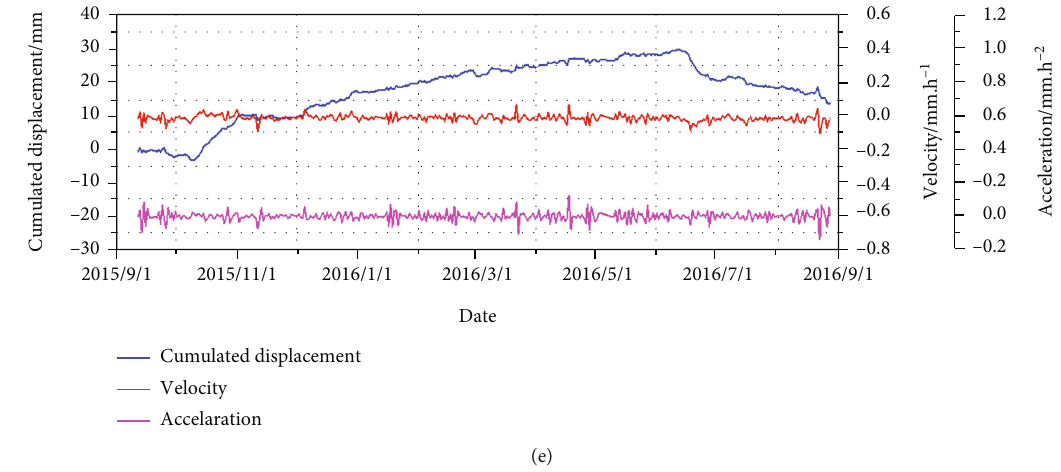
Figure 7: Archived monitoring data: (a) 1-1 point, (b) 2-1 point, (c) 3-1 point, (d) 3-2 point, and (e) 4-1